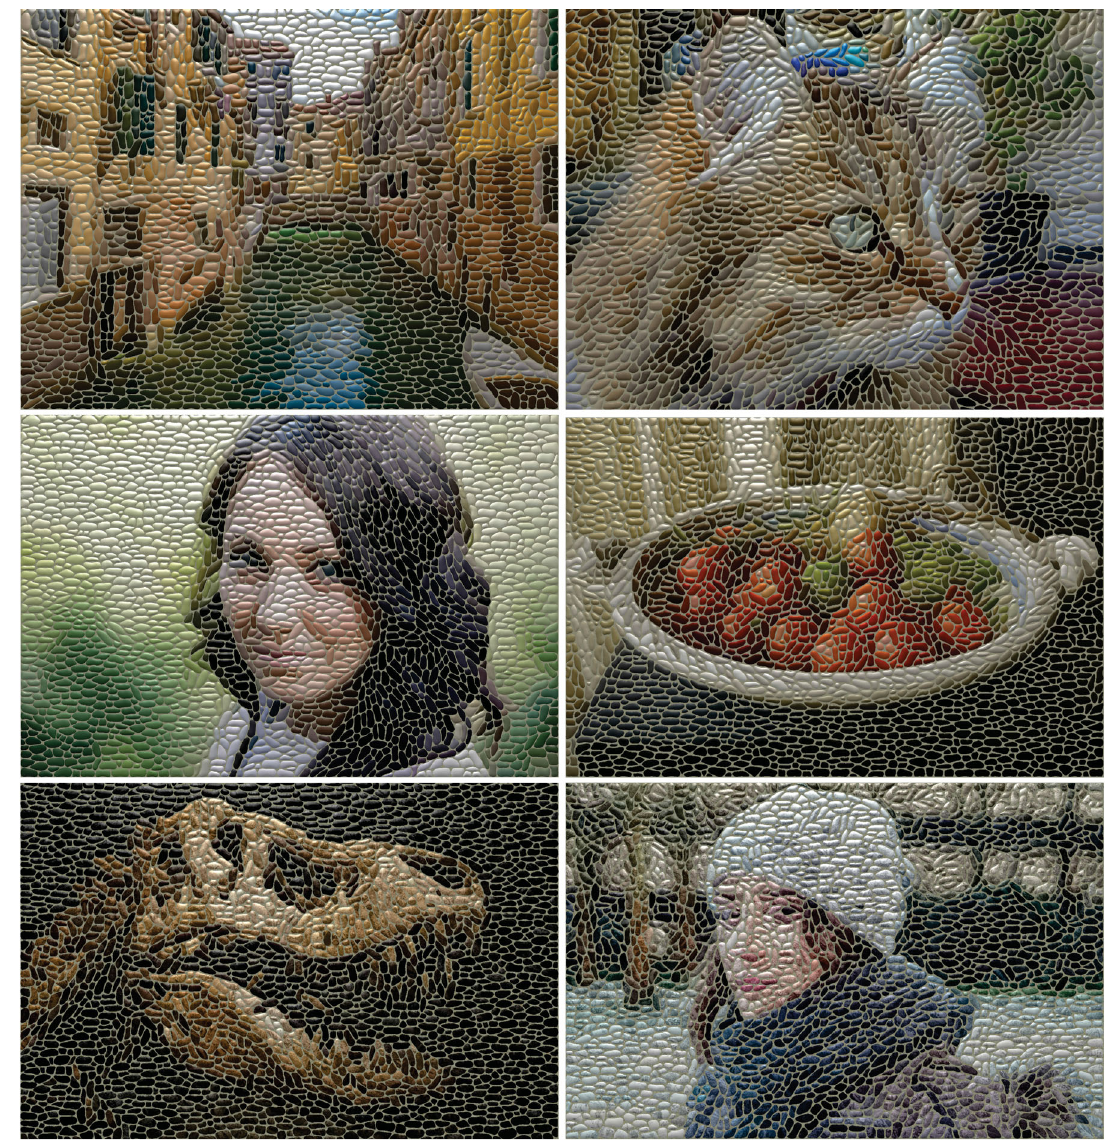
Fig. 10 Results. Top two rows: without texture. Bottom row: using marble